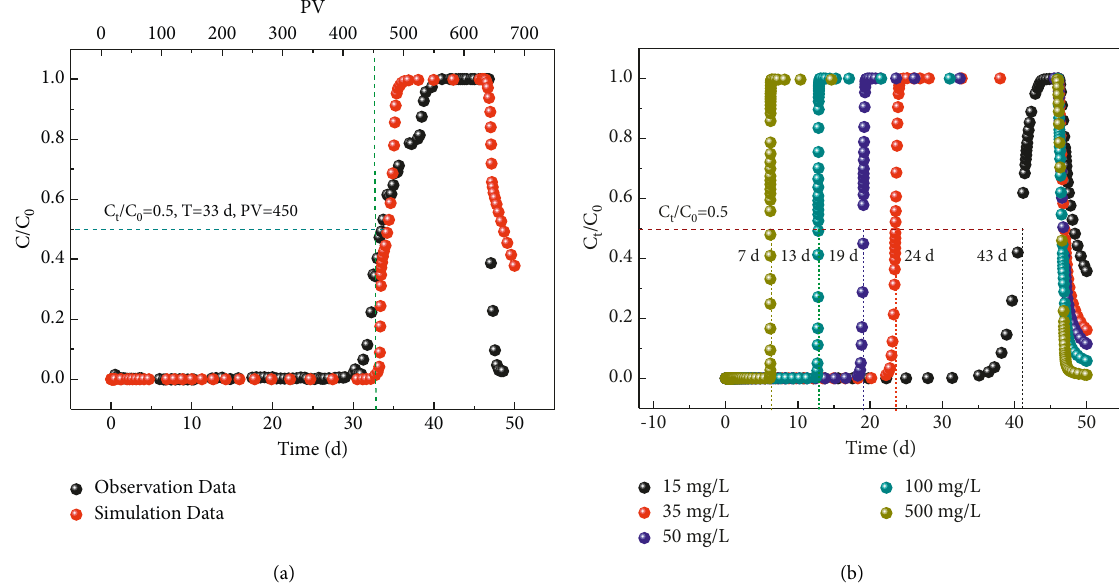
Figure 3: (a) Experimental and fitting breakthrough curve of copper for a column packed with hydroxyapatite. The input concentration of copper is 20mg/L. Adsorbent mass is 20g. (b) Predicting breakthrough curve of copper for a column packed with hydroxyapatite for different copper concentrations.